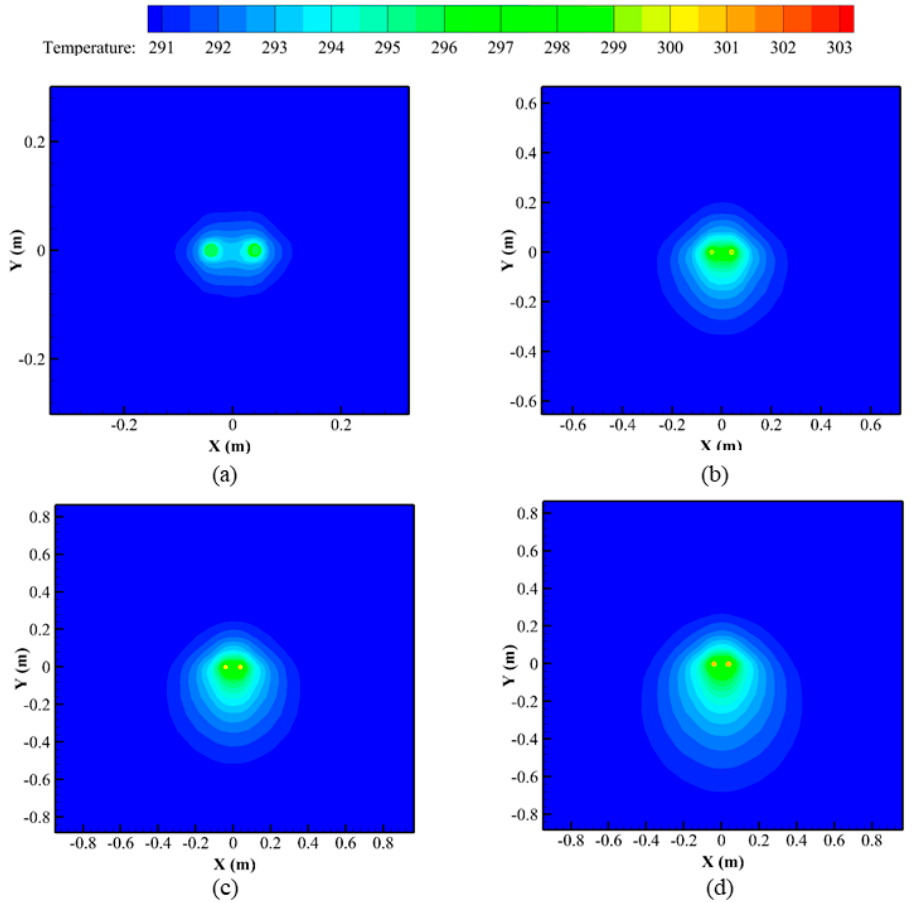
Figure 12. Temperature distribution of the cross ‐ section Z = 0 with a hydraulic conductivity of 2 × 10 − 6 m/s. ( a ) After 2 h; ( b ) after 16 h; ( c ) after 32 h; ( d ) after 48 h.